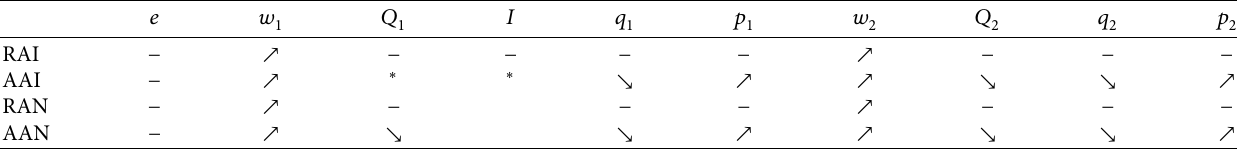
∗ ” indicates that the change in variables with θ r . “